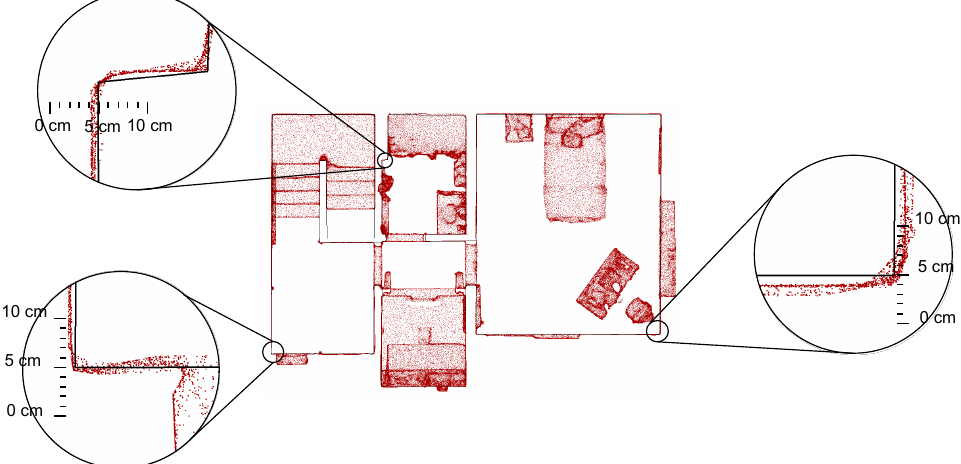
Figure 3. Comparison of the annotated GT floorplan and wall point clouds. The red part represents the projection of the point cloud on the 2D plane after removing the ceiling and floor, and the black line represents the annotated GT